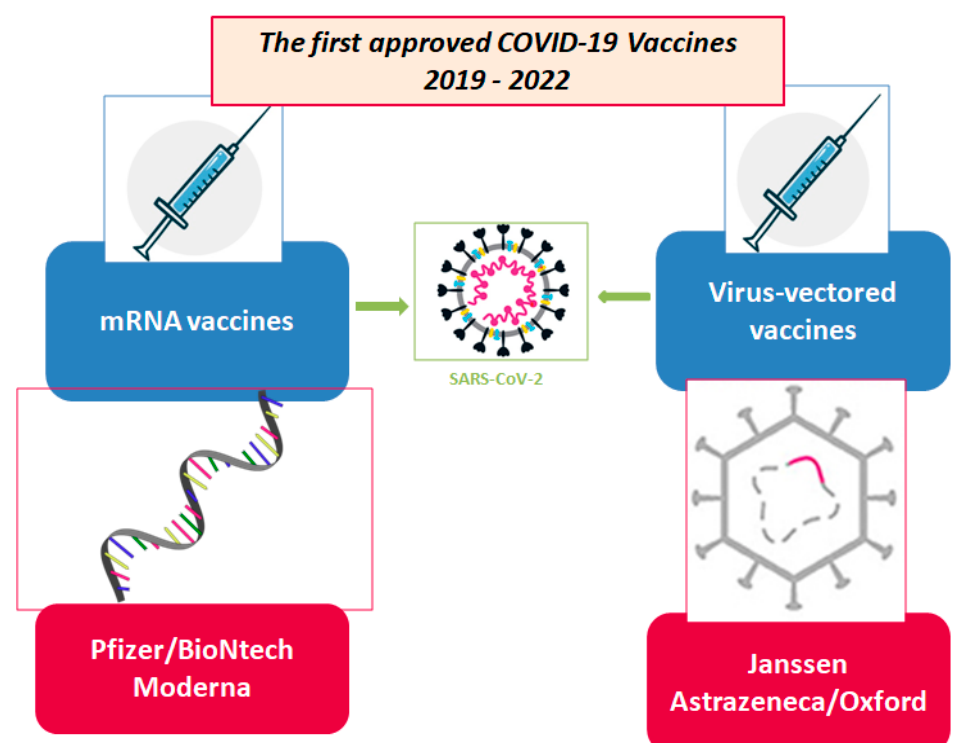
Figure 3. Technologies for SARS-CoV-2 first generation of vaccine candidates. Adapted from [4]. Table 1. Principal data for four vaccines to COVID-19 about indications and dosage.